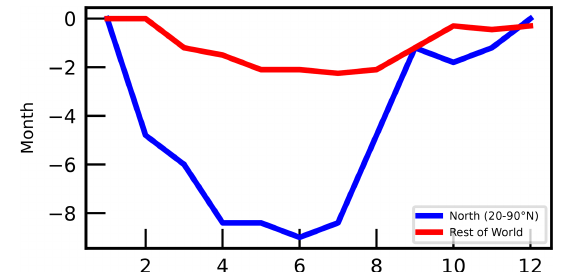
Figure A1. Assumed temporal distribution for OH reduction (%) in the Northern Hemisphere (20–90 ◦ N, blue line) and the rest of the world (red line) for our sensitivity